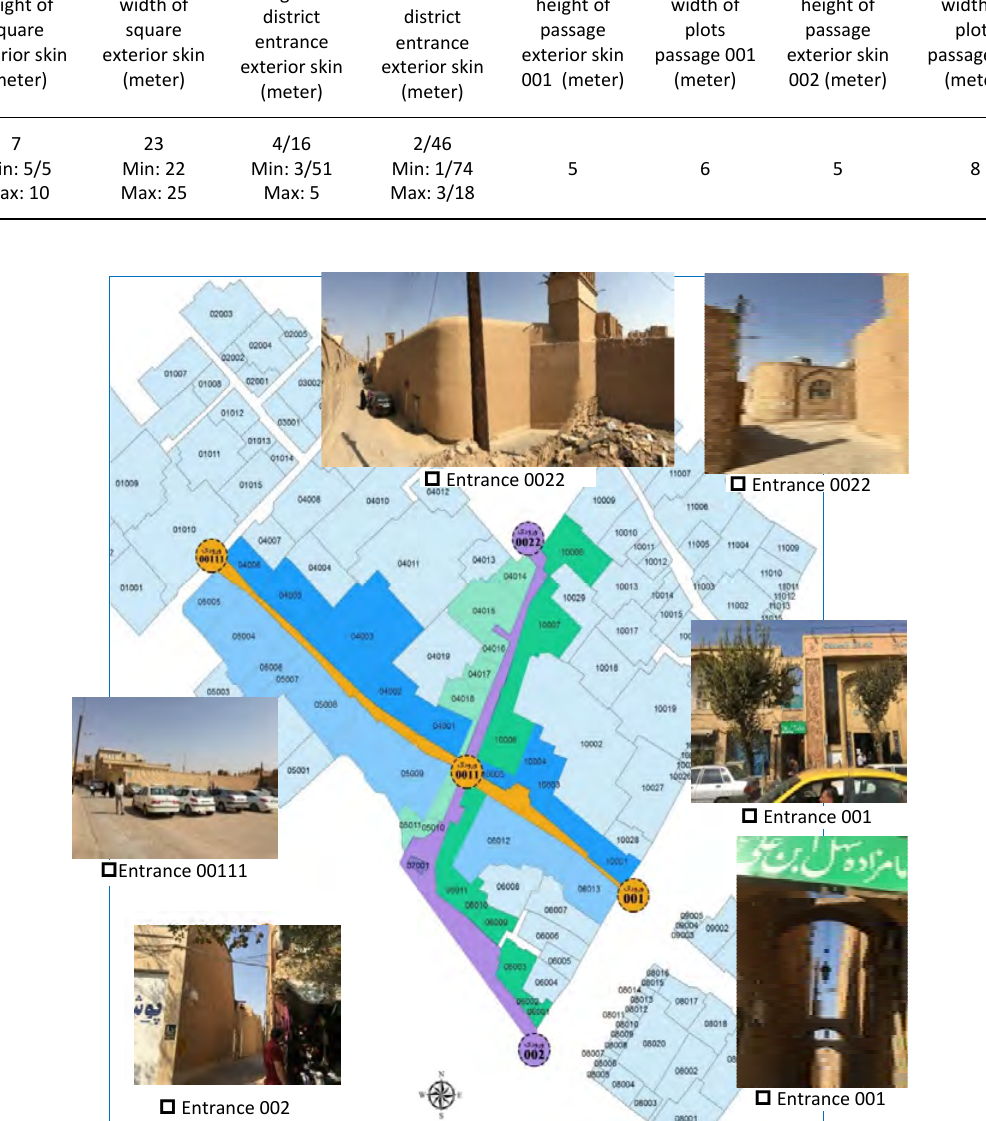
Fig. 7: Location of the passages, and main entrances of Sahl Ibn Ali district of Yazd